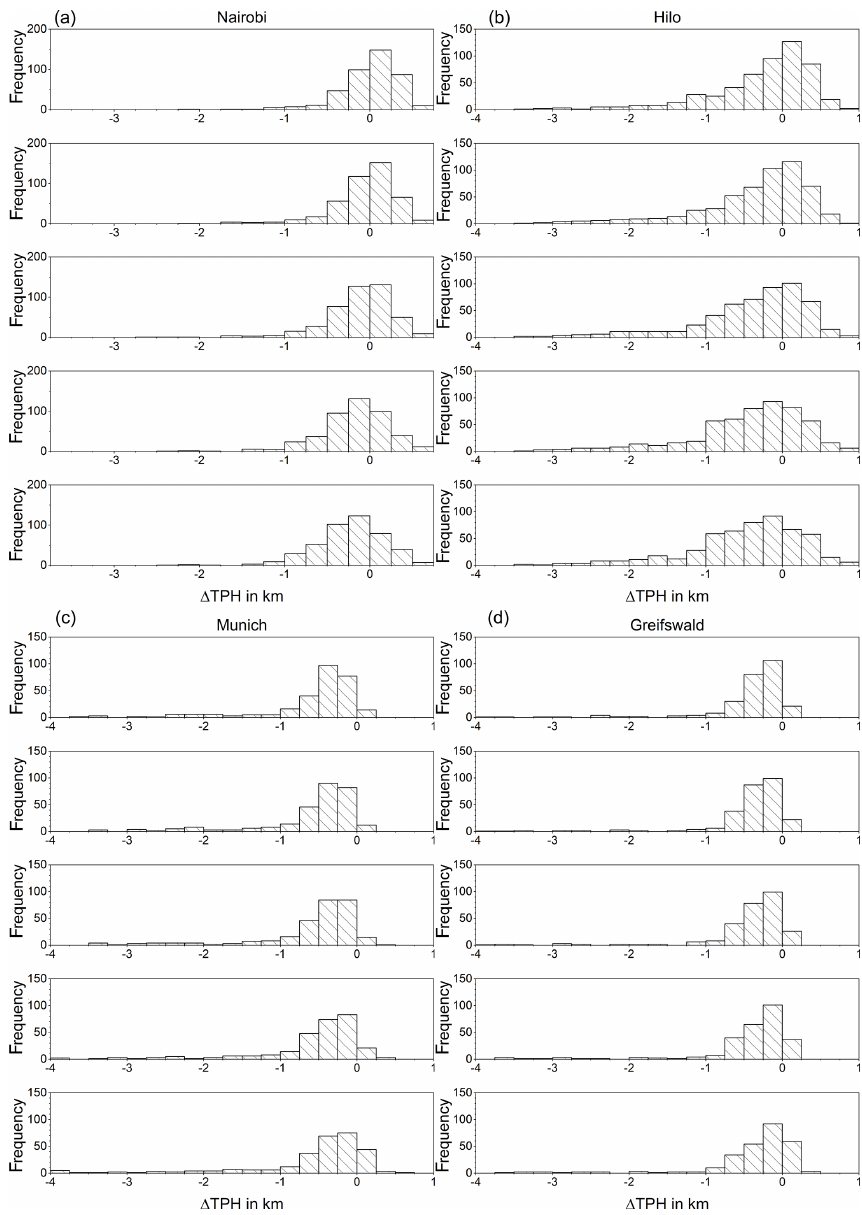
Figure 2. Histograms of mean tropopause height ( (cid:49) TPH) offsets ( (cid:49) TPH) of degraded temperature profiles (Gaussian kernel) with resolutions of 1 to 5km in steps of 1km (from top to bottom) for Nairobi (a) , Hilo (b) , Munich (c) , and Greifswald (d)